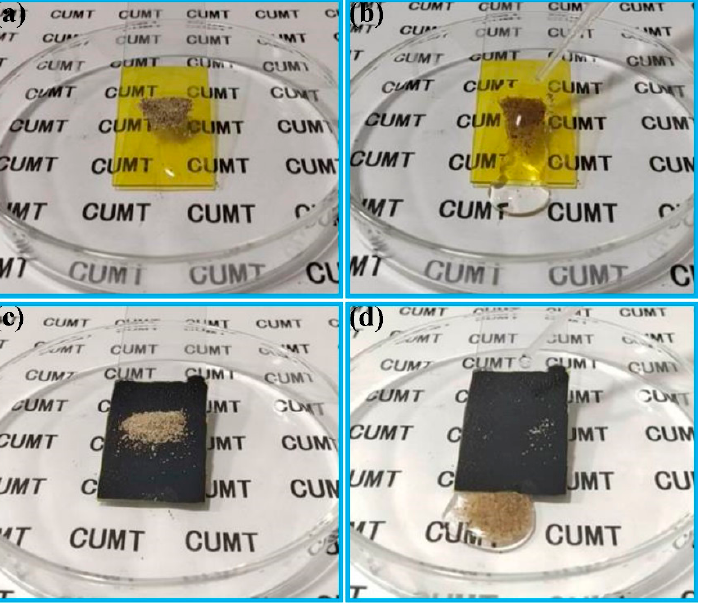
Figure 6. ( a ) Image of sand particles on the PI surface; ( b ) self-cleaning property of the PI surface; ( c ) image of sand particles on the FCS coating; and ( d ) self-cleaning property of the FCS coating.